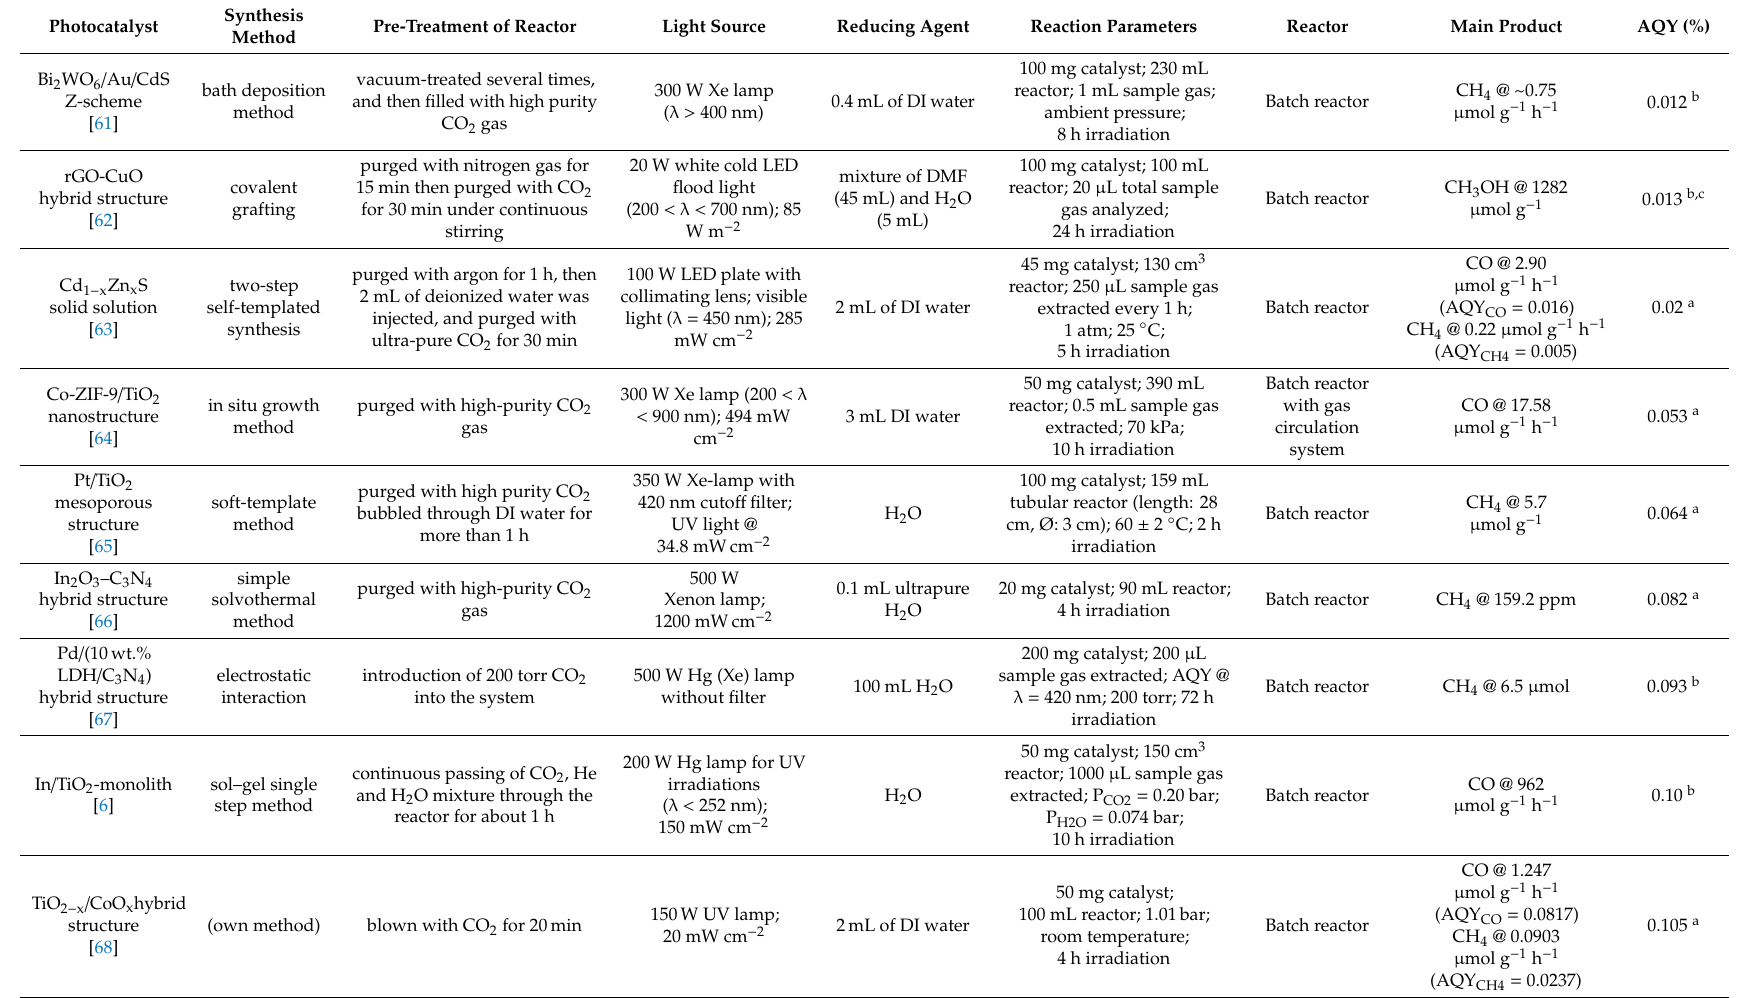
Table 2. Summary of operating parameters and yields used by other research works for photocatalytic CO 2 reduction using Batch